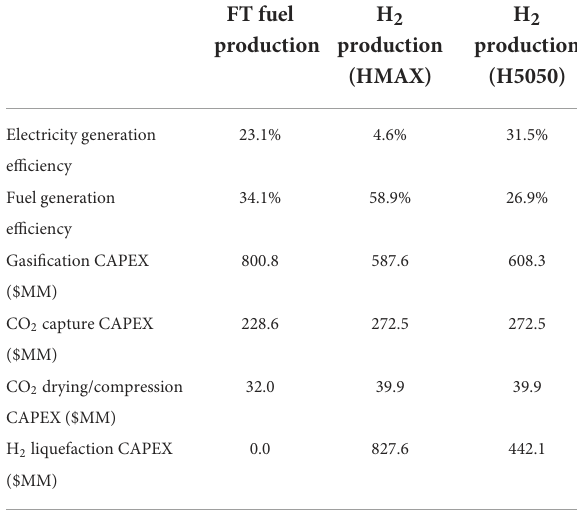
TABLE 4 Data used to generate plots for Case 2, based on data from Larson et al. (2009) and Baker et al. (2020).